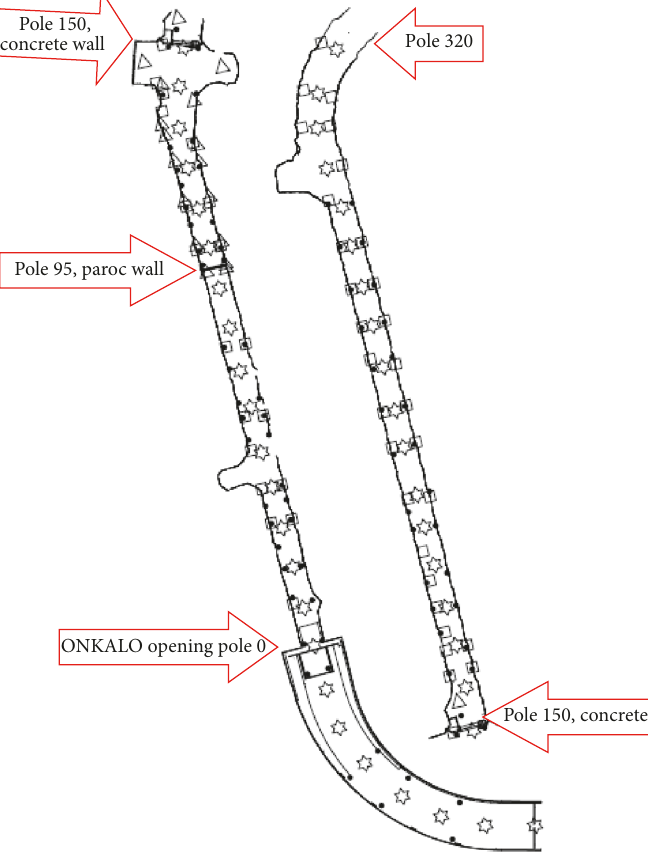
Figure 14: Measurement configurations 1–4.